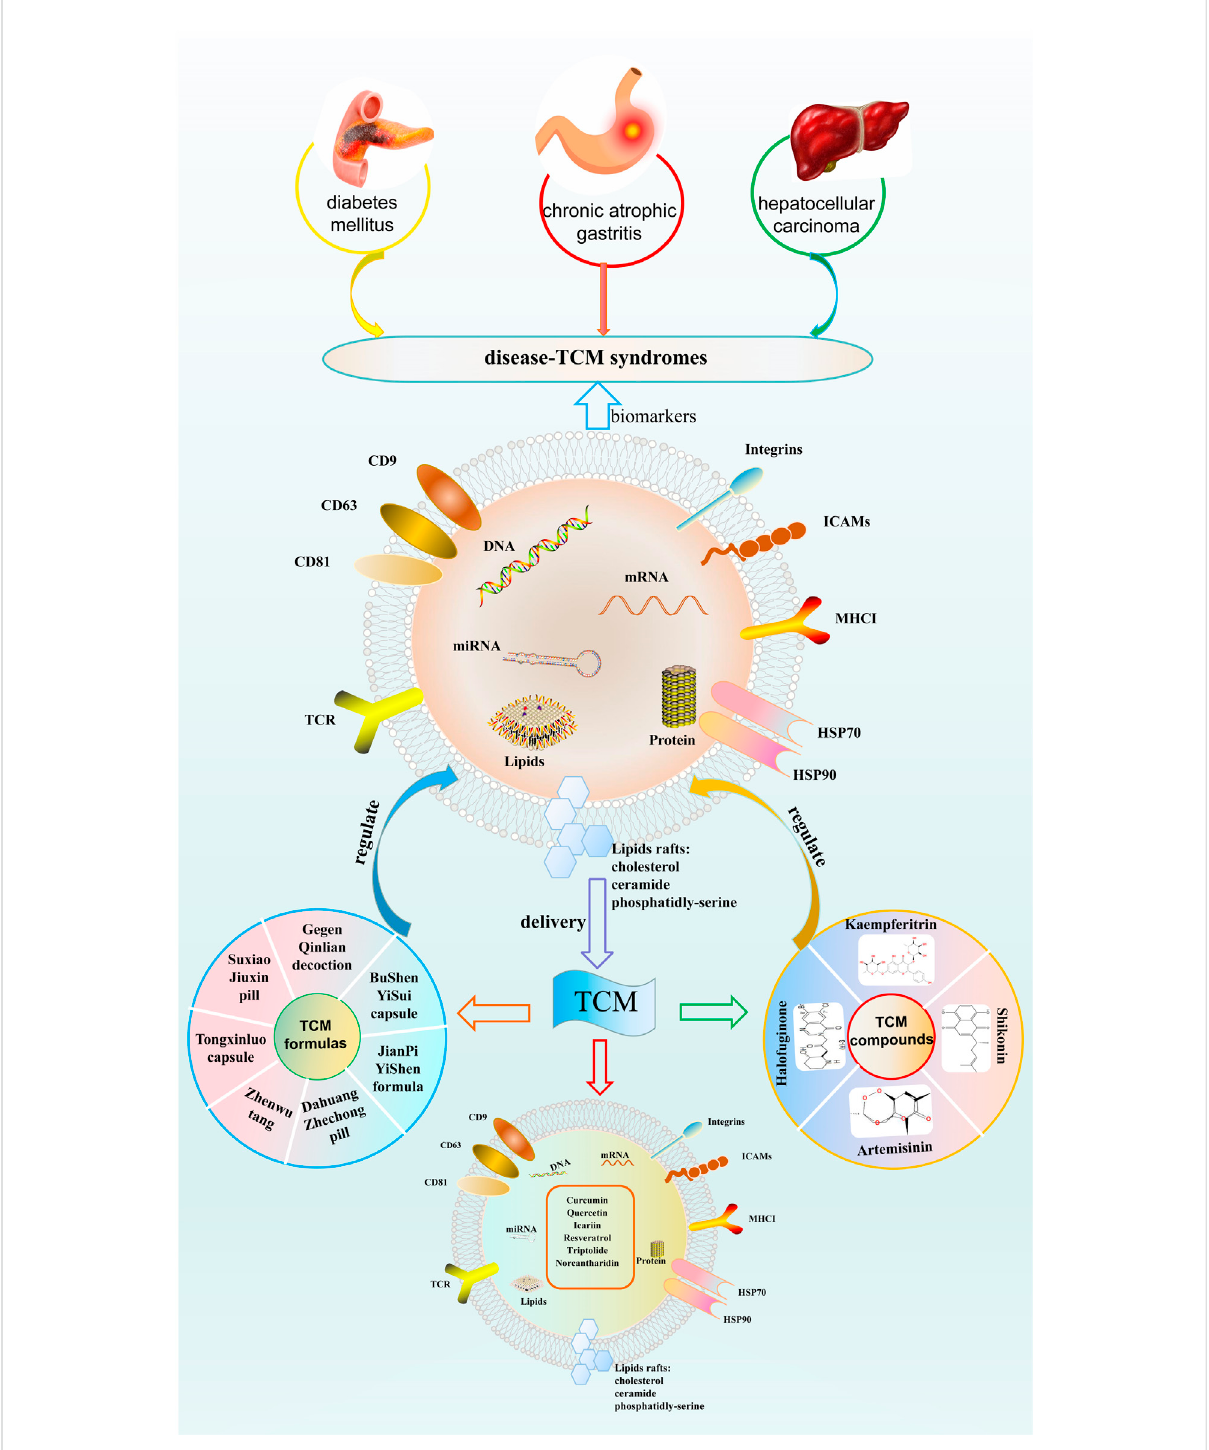
The interaction between exosomes and traditional Chinese medicine. TCM, traditional Chinese